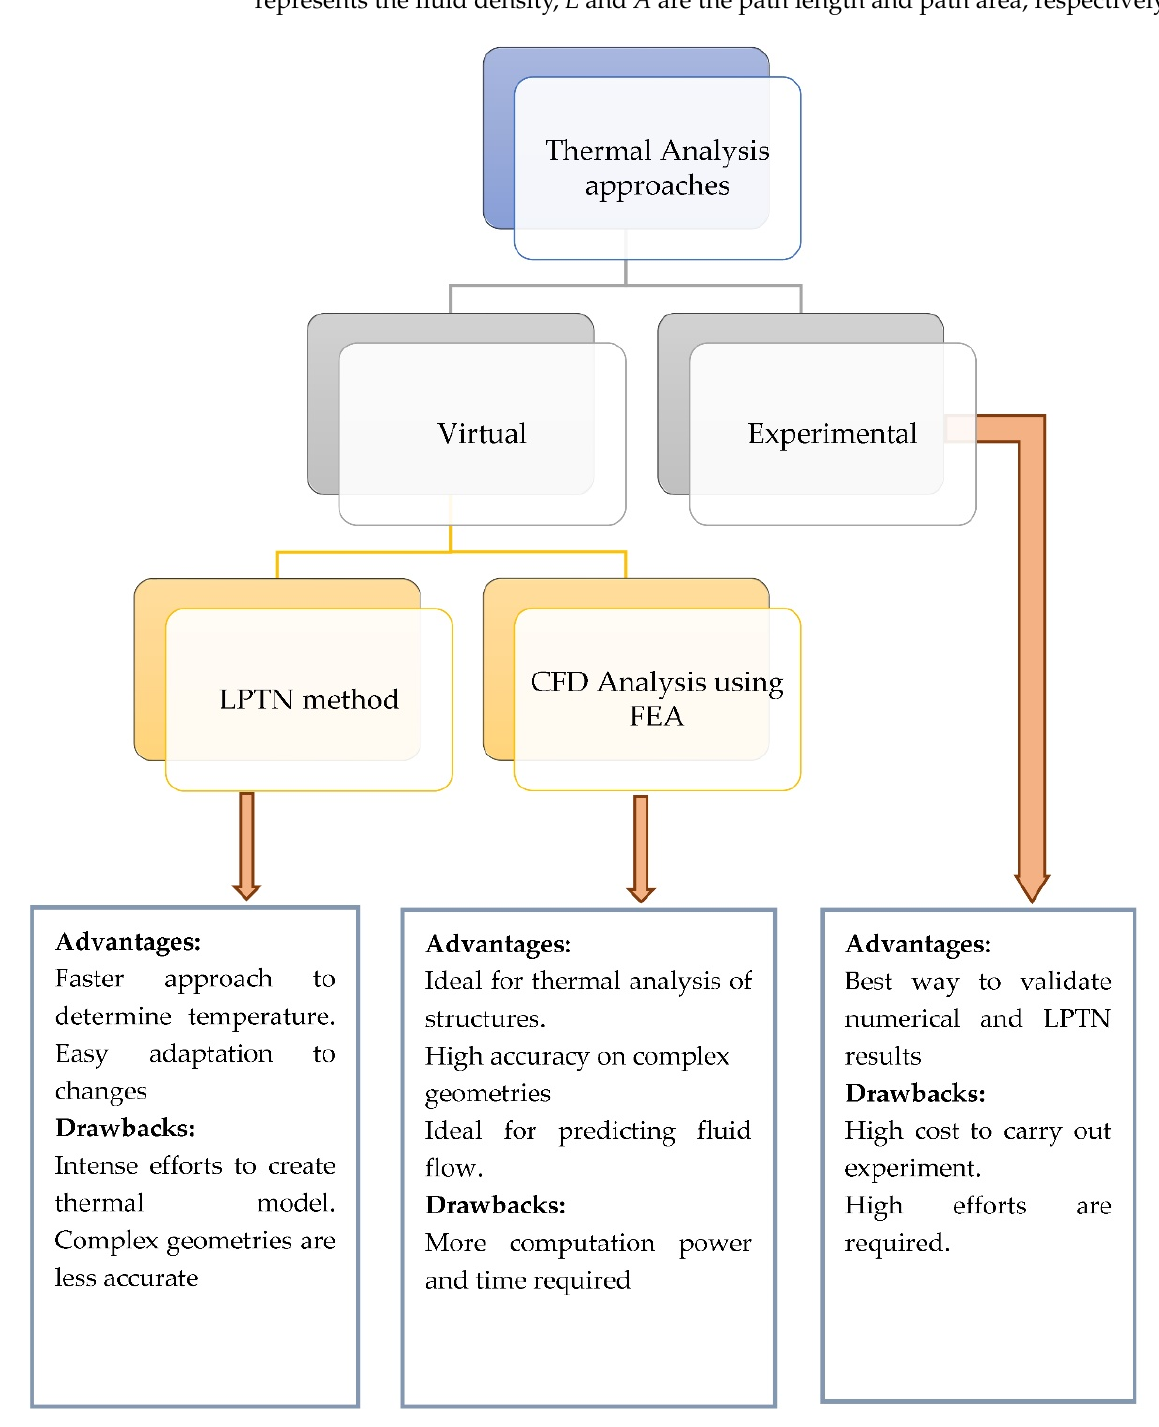
Figure 2. Comparison of different thermal analysis approaches.